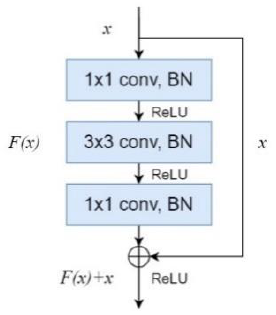
Figure 5. The structure of the residual block.